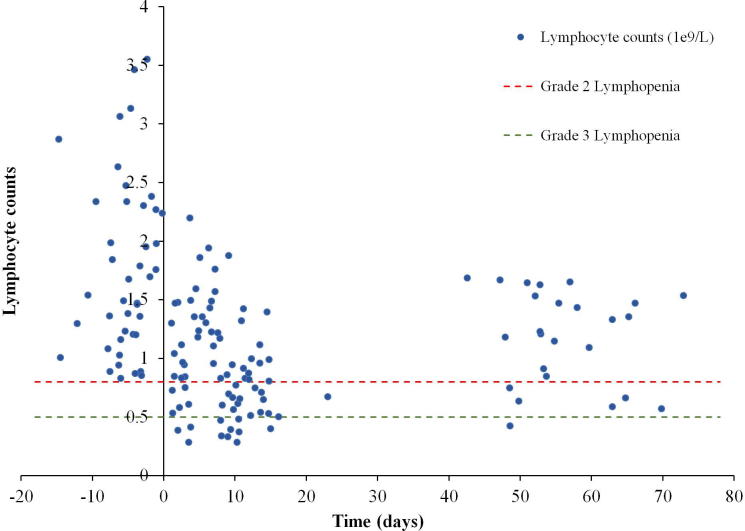
Association between lymphocyte counts and RT time. Scatter plot shows lymphocyte counts against time where day zero is the first day of RT and negative time represents days prior to RT. Red and green horizontal dotted lines correspond to grade 2 and 3 lymphopenia respectively based on the CTCAE v4.0. To avoid quantization in the scatter plot, appropriate random values were added to time and lymphocyte counts. (For interpretation of the references to colour in this figure legend, the reader is referred to the web version of this article.)